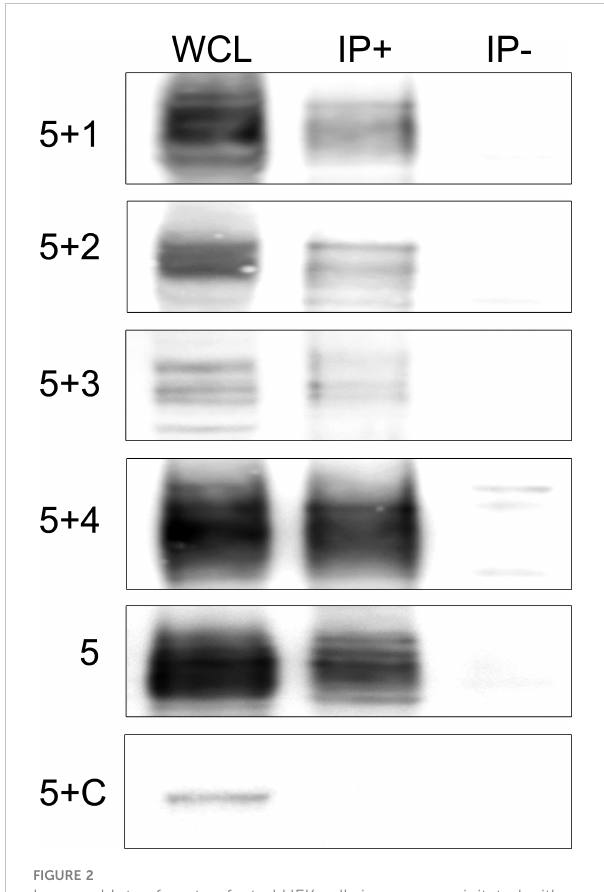
FIGURE 2 Immunoblots of co-tranfected HEK cells immunoprecipitated with patients ’ IgLON5 antibodies. HEK cells co-transfected with IgLON5 and each of the other IgLON family members: fi rst row (IgLON5 + IgLON1), 2nd row IgLON2 (5+2), 3rd row (5+3), and 4th row (5+4). The 5th row corresponds to HEK cells transfected only with IgLON5, and the 6th row HEK cells co-transfected with IgLON5 and CASPR2 (5+C). Left column: Whole cell lysates (WCL); middle column: Immunoprecipitates of transfected HEK cells using patients ’ IgLON5-abs (IP+); right column: Immunoprecipitates of transfected cells using Ctrl-abs (IP). Each row was incubated with commercial antibodies against the corresponding proteins: IgLON1, 2,3,4,5 and